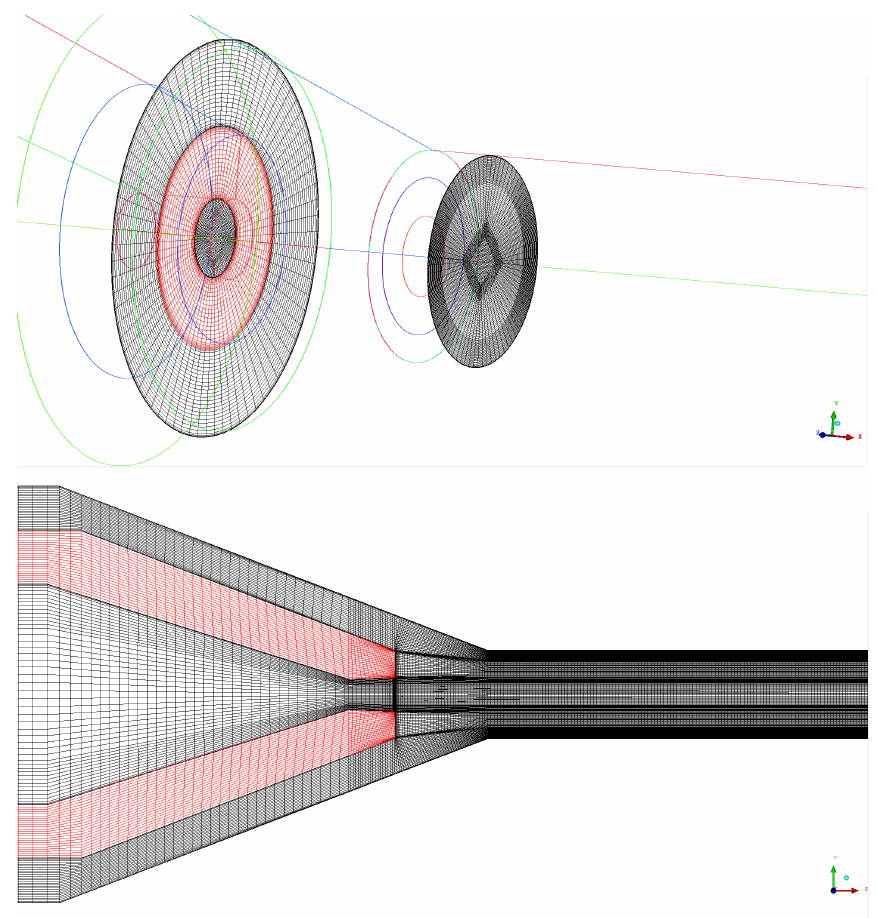
Figure 5. Generic ejector geometry with geometry parameters. The red color signifies solid